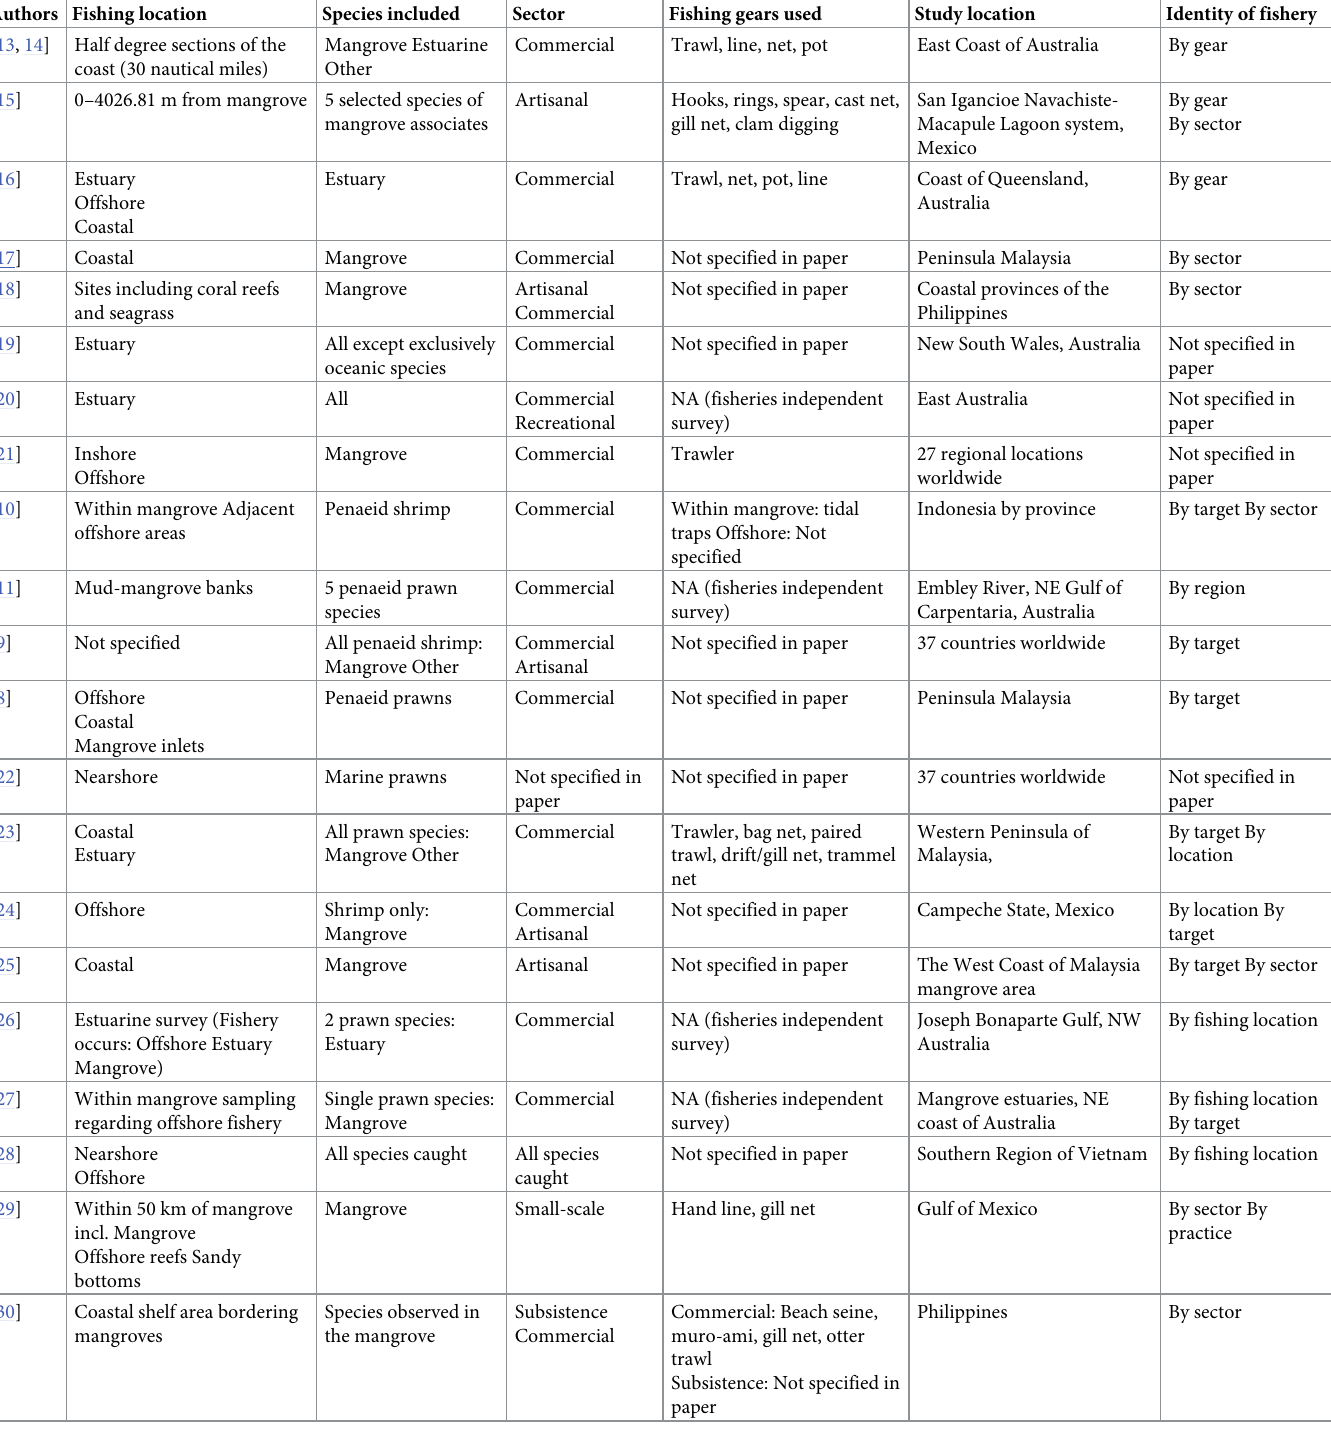
Table 1. Characteristics used to describe mangrove-associated fishing in the quantitative literature by fishing location, species included from catches (mangrove associated or otherwise), fishing sectors included, fishing gear used and how the fishery is identified. The list of papers explored, representing studies which have quantified mangrove-fishery linkages, were compiled by Carrasquilla-Henao et al.